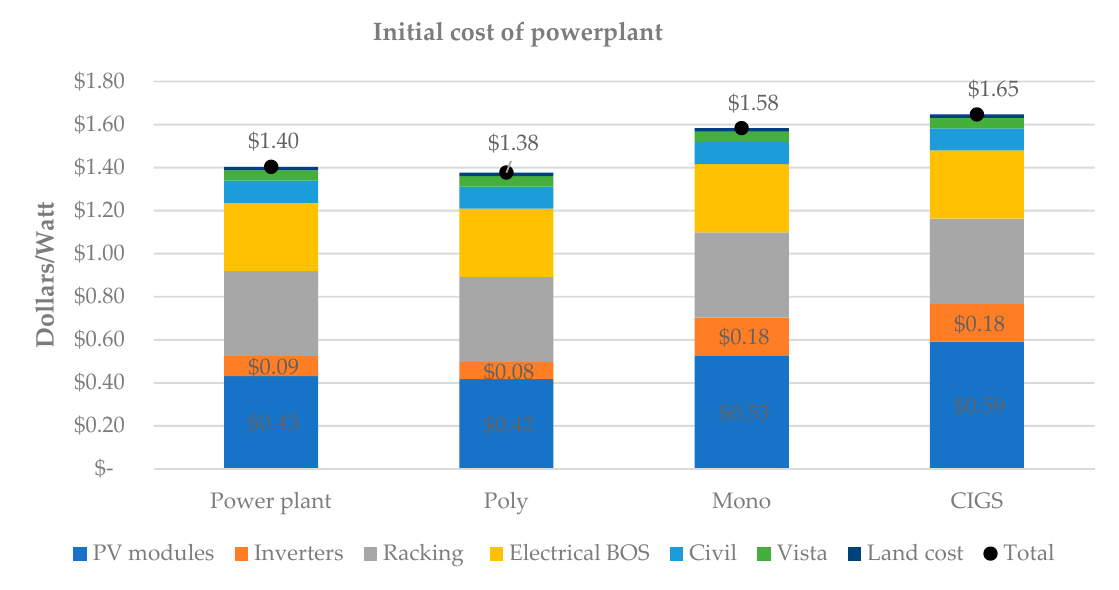
Figure 13. Discounted LCOE for each technology.